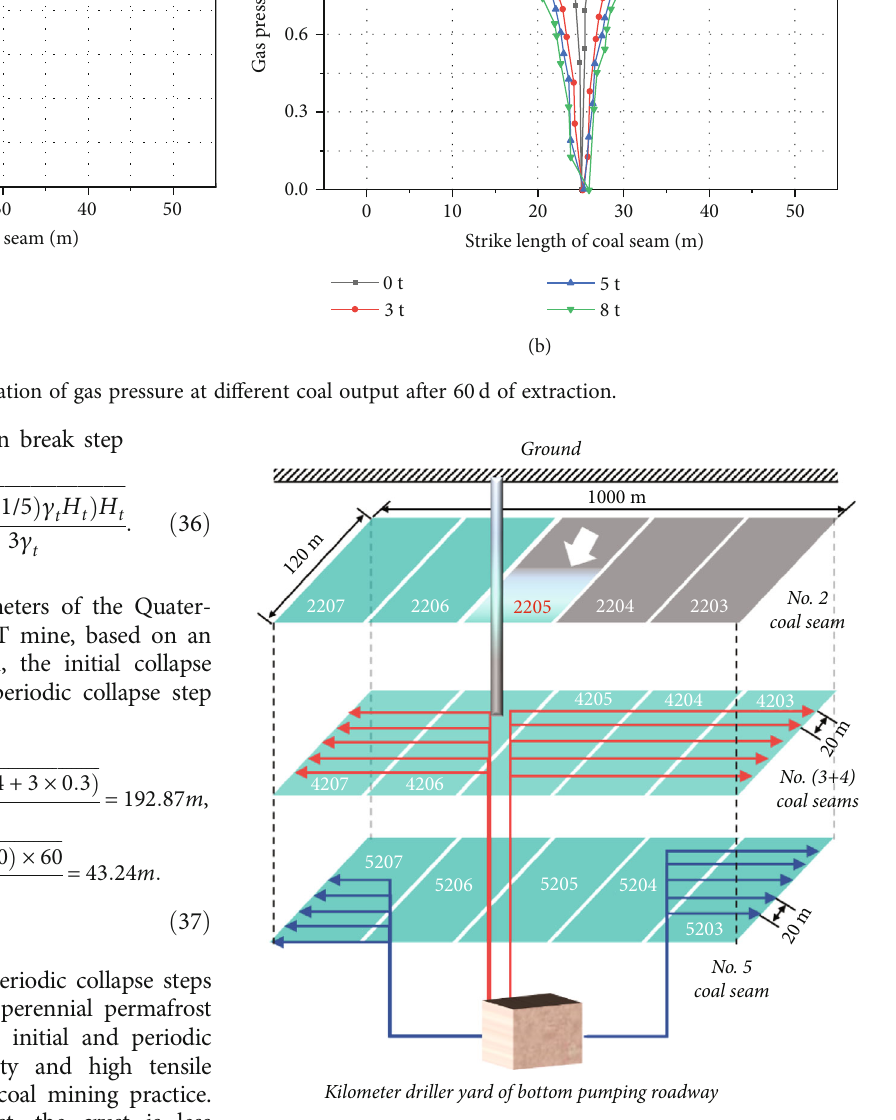
Figure 11: Design of directional drilling group prepumping in protective layer mining + fl oor extraction